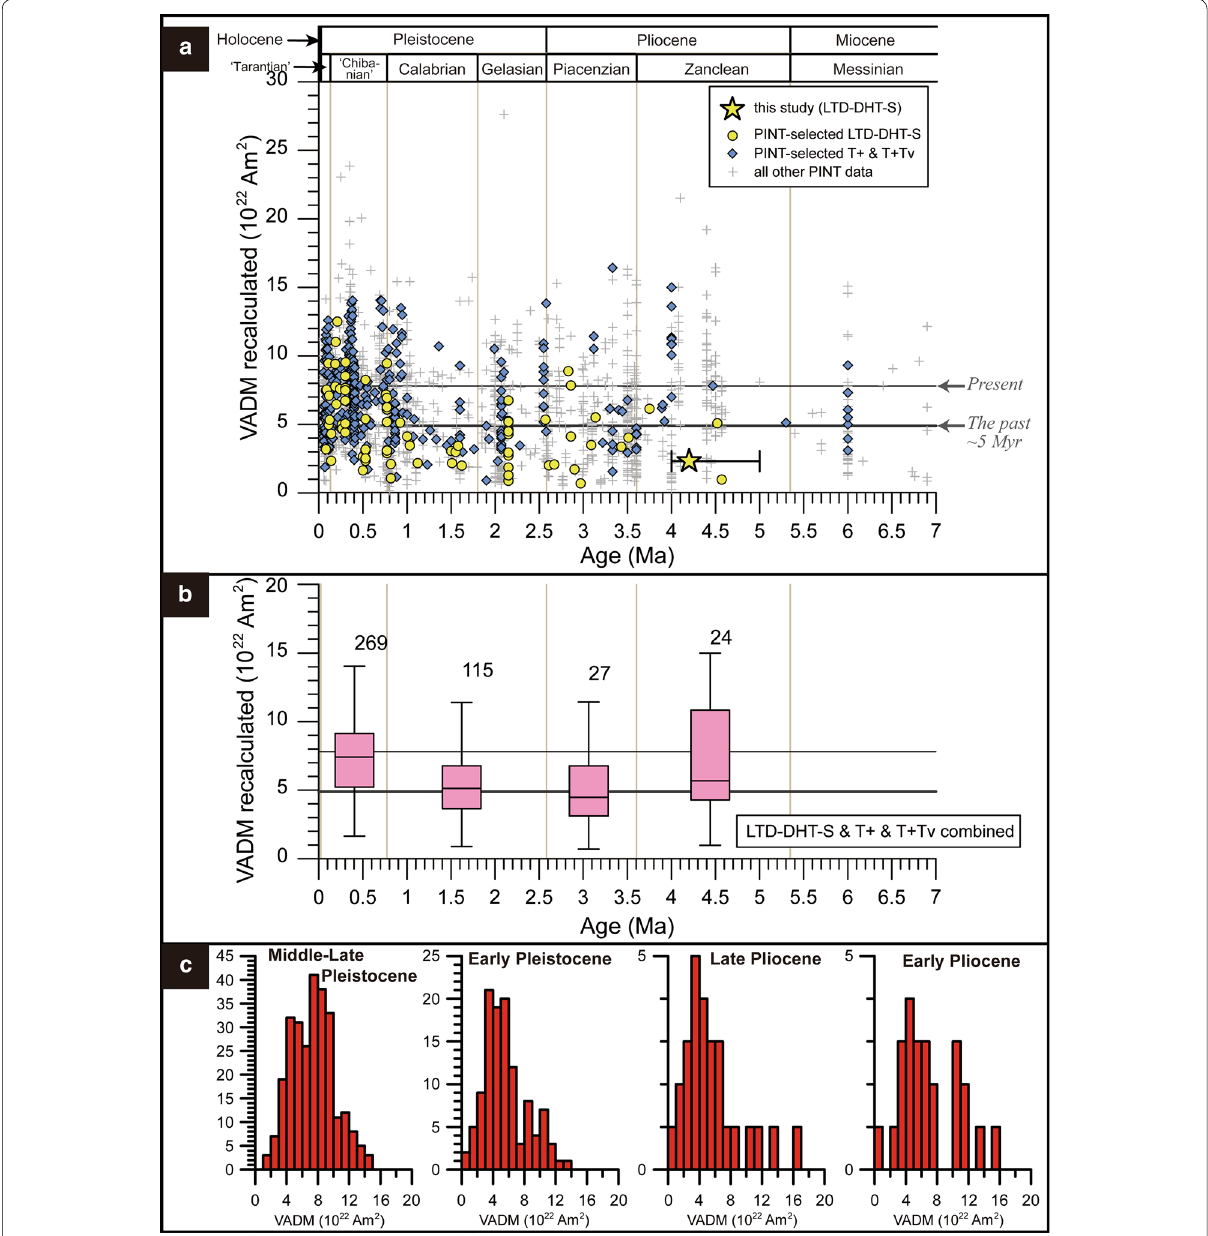
Fig. 6 Comparison of API data in VADM obtained in this study with those of the PINT database. a Published VADM data (recalculated in this study; grey cross symbols) for the past 7 Myr (actually 7 to 0.05 Ma), which were downloaded from the PINT database (version 2015.05; http://earth .liv.ac.uk/pint/; accessed July, 2018), represented as a VADM versus age plot together with the Baengnyeong Island data (yellow stars) from this study. Yellow circles and blue diamonds are, respectively, the LTD‑DHT‑S and T / T Tv data meeting the criteria ( N F 3, σ F 20% and having + + ≥ ≤ independent paleodirection determination, which must represent normal or reverse polarity) (see http://earth .liv.ac.uk/pint/ for the abbreviations of the PI methods). The thin (thick) horizontal line is the dipole intensity for the present‑day (for the past approximately 5 Ma by Wang et al. 2015). The geologic time scales are also shown together with the abscissa axis. b Quartile box plots of the extracted VADM data (yellow circles and blue diamonds in Fig. 6a) including new data from this study for individual geologic time spans (0.050–0.781 Ma, 0.781–2.580 Ma, 2.580–3.600 Ma, and 3.600–5.333 Ma). Boxes represent the interquartile range, horizontal lines in the boxes are median values, and error bars represent the full range. The Arabic numeral above each upper error bar is the number used for each plot. The coordinates of boxes for x ‑axis are given arbitrarily. The thin and thick horizontal lines are same as the shown in a . c Histograms of the extracted VADMs for the individual geologic time spans (0.050–0.781 Ma, 0.781–2.580 Ma, 2.580–3.600 Ma, and 3.600–5.333